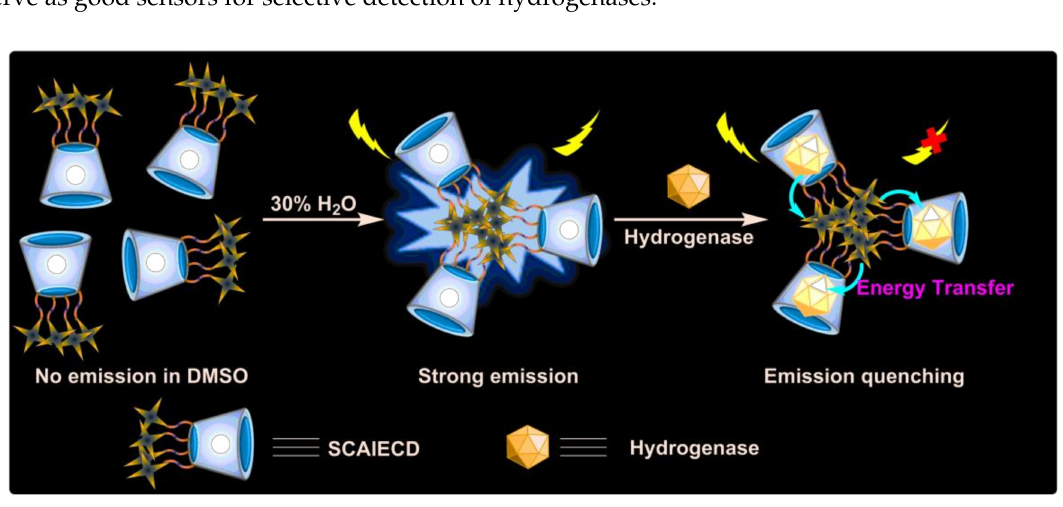
Figure 4. Sensing mechanism of SCAIECD